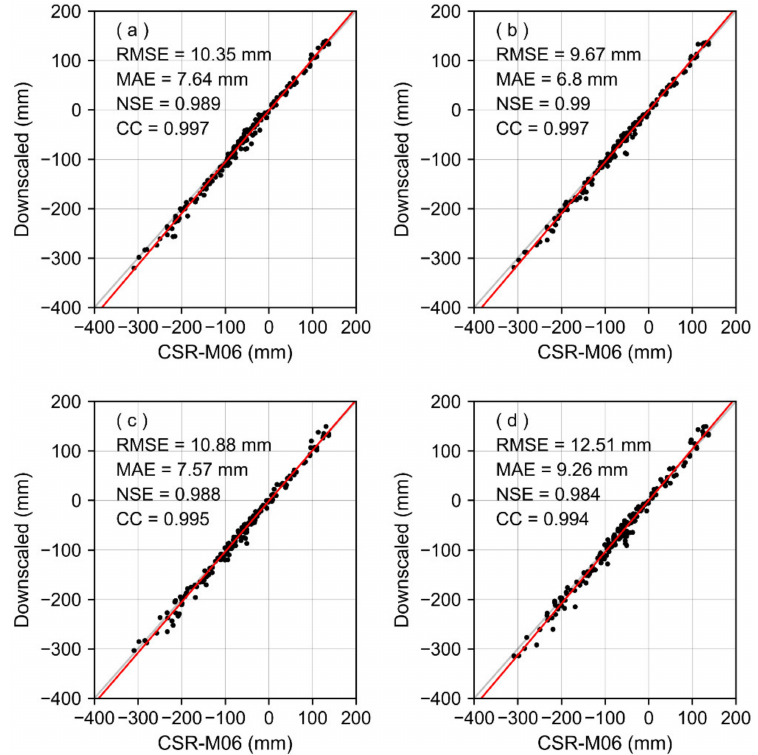
Figure 8. Regression analysis between the downscaled results and CSR-M06 model in Guantao County. (( a ): WS3, ( b ): WS5, ( c ): WS7, ( d ):